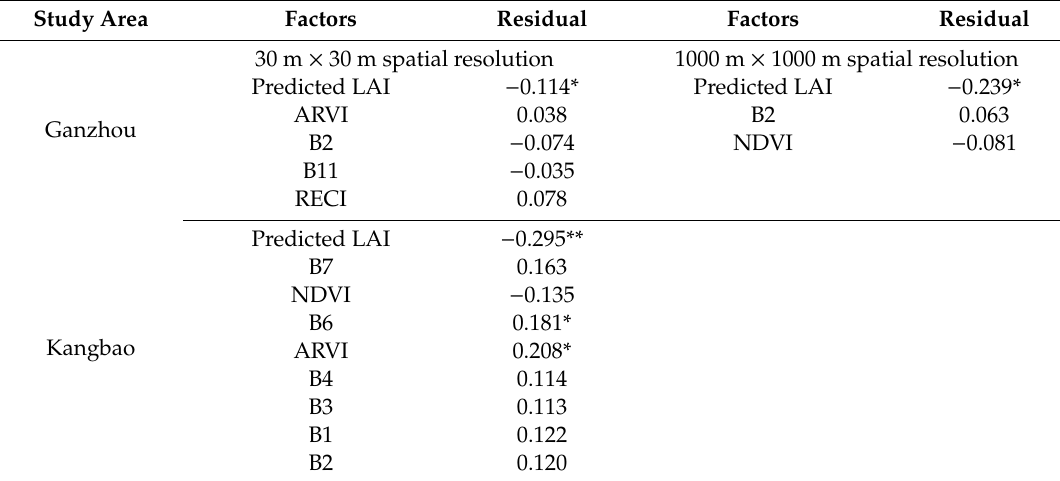
Table 5. The Pearson correlation coe ffi cients of the residuals with the predicted LAI and the spectral variables used by the modified kNN in Ganzhou and Kangbao (Note: * at the significance level of 0.05, and ** at the significance level of 0.01).